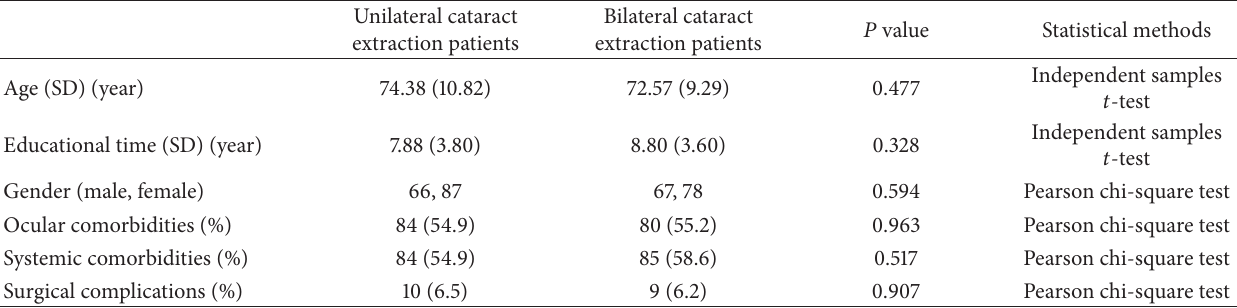
Table 1: Clinical characteristics compared in unilateral and bilateral cataract extraction patients.